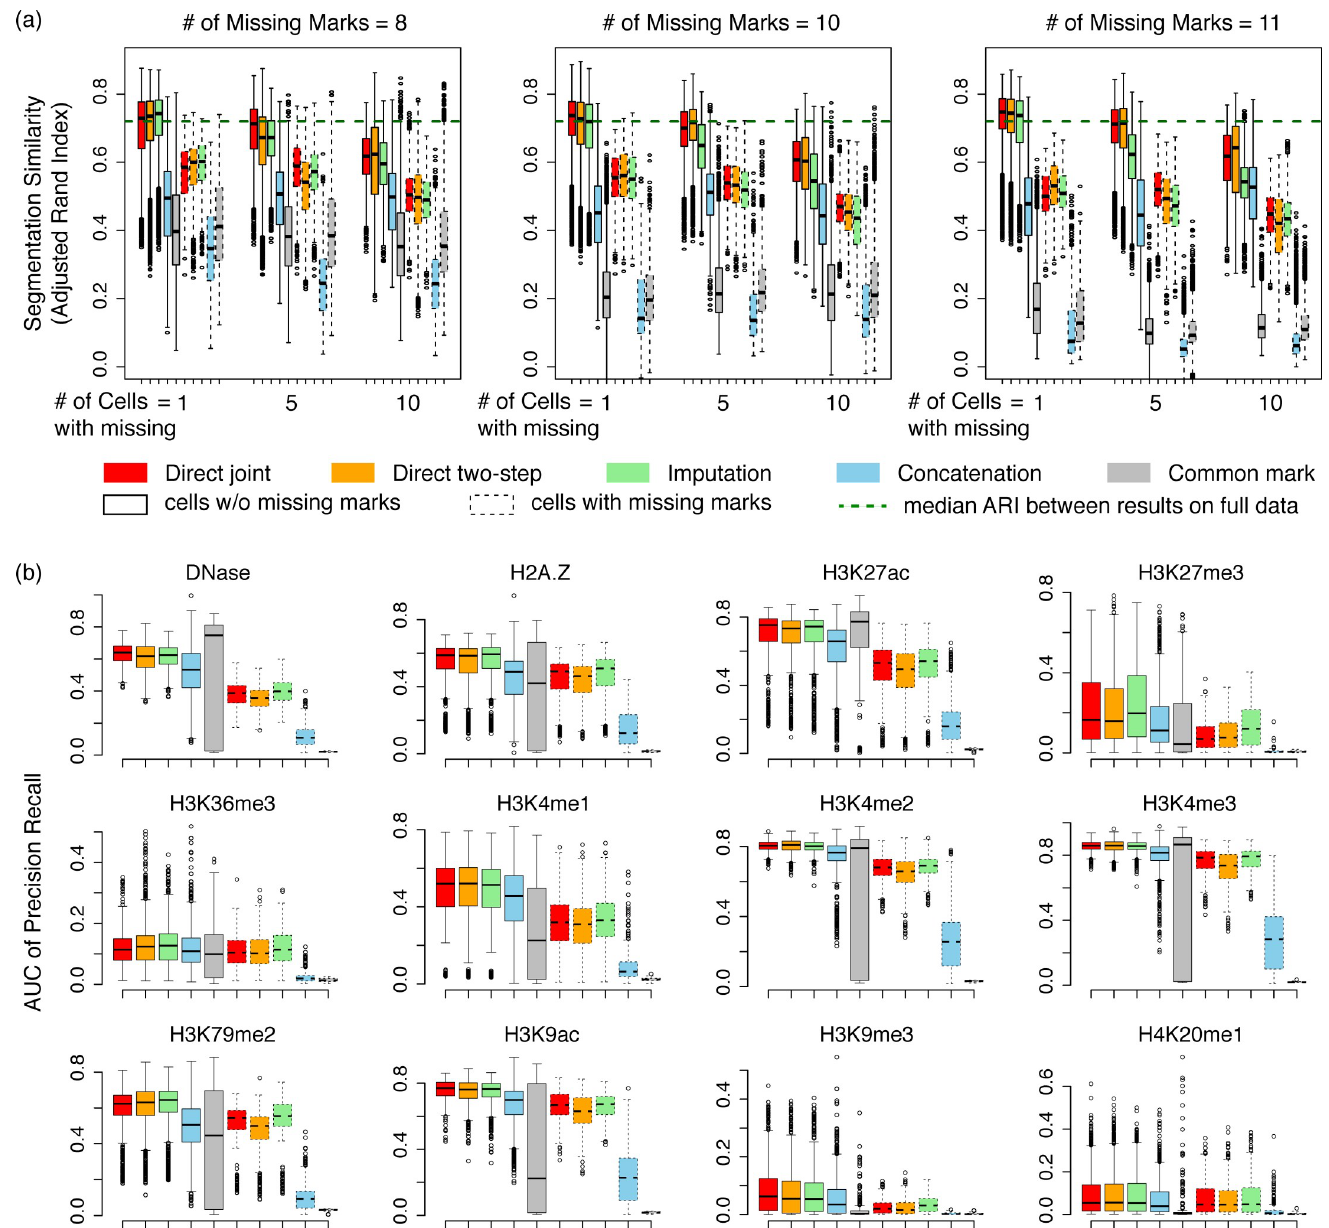
Fig 2. Comparison of segmentation accuracy. (a) Similarity (y-axis) of segmentation produced by different methods on partial data compared with the results obtained from the full data. Results are separated by the number of cell types with missing marks and the number of missing marks in each cell type. Results are further separated by cell types without missing marks (solid boxes) and cell types with missing marks (dashed boxes). Green dashed line indicates median similarity between independent IDEAS runs on the full data set. (b) AUC of precision-recall for predicting peaks of chromatin marks at FDR 0.05 by chromatin states. Results are separated by cell types with the mark being present (solid boxes) and cell types without the mark (dashed boxes).